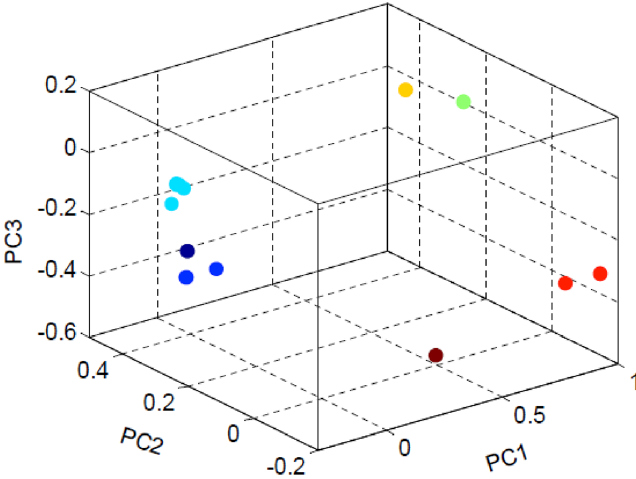
Figure 6. Scatter plot of the first three PC values. Circle (aqua color): Cluster 1 consists of Homo sapiens ( Berber , Chinese , Georgean, Yoruba , and Neanderthal) ; Circle (blue color): Cluster 2 consists of chimpanzees (Pan_troglodytes_1, Pan_troglodytes_2, Pan_troglodytes_3); Circle (indigo color): Cluster 3 consists of pygmy chimpanzees (Pan_paniscus_1, Pan_paniscus_2) ; Circle (red color): Cluster 4 consists of gorillas (Gorilla_ gorilla_1, Gorilla_gorilla_2, Gorilla_gorilla_gorilla) ; Circle (yellow color): Cluster 5 consists of Sumatran orangutan ( Pongo_pygmaeus_abelii_1 , Pongo_pygmaeus_abelii_1 ); Circle (lime color): Cluster 6 consists of Bornean orangutan ( Pongo_pygmaeus_1, Pongo_pygmaeus_2 ); Circle (maroon color): Cluster 7 consists of Gibbon (Hylobates lar) . Note that some data points are coincident due to close PC values of the organisms in the same cluster.